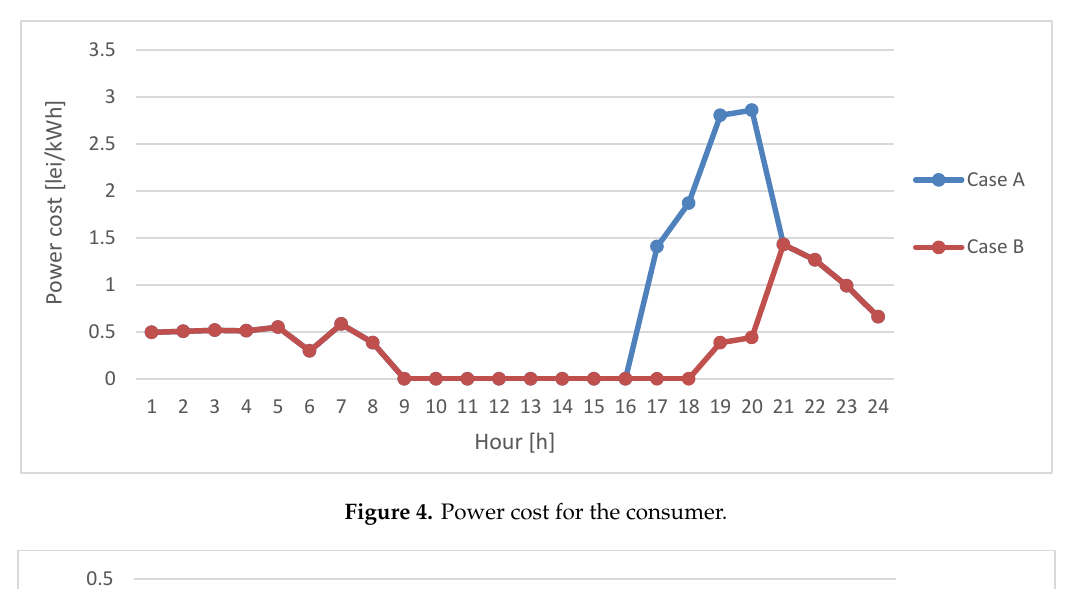
Figure 3. Power demand of the load (household appliances) (case B).